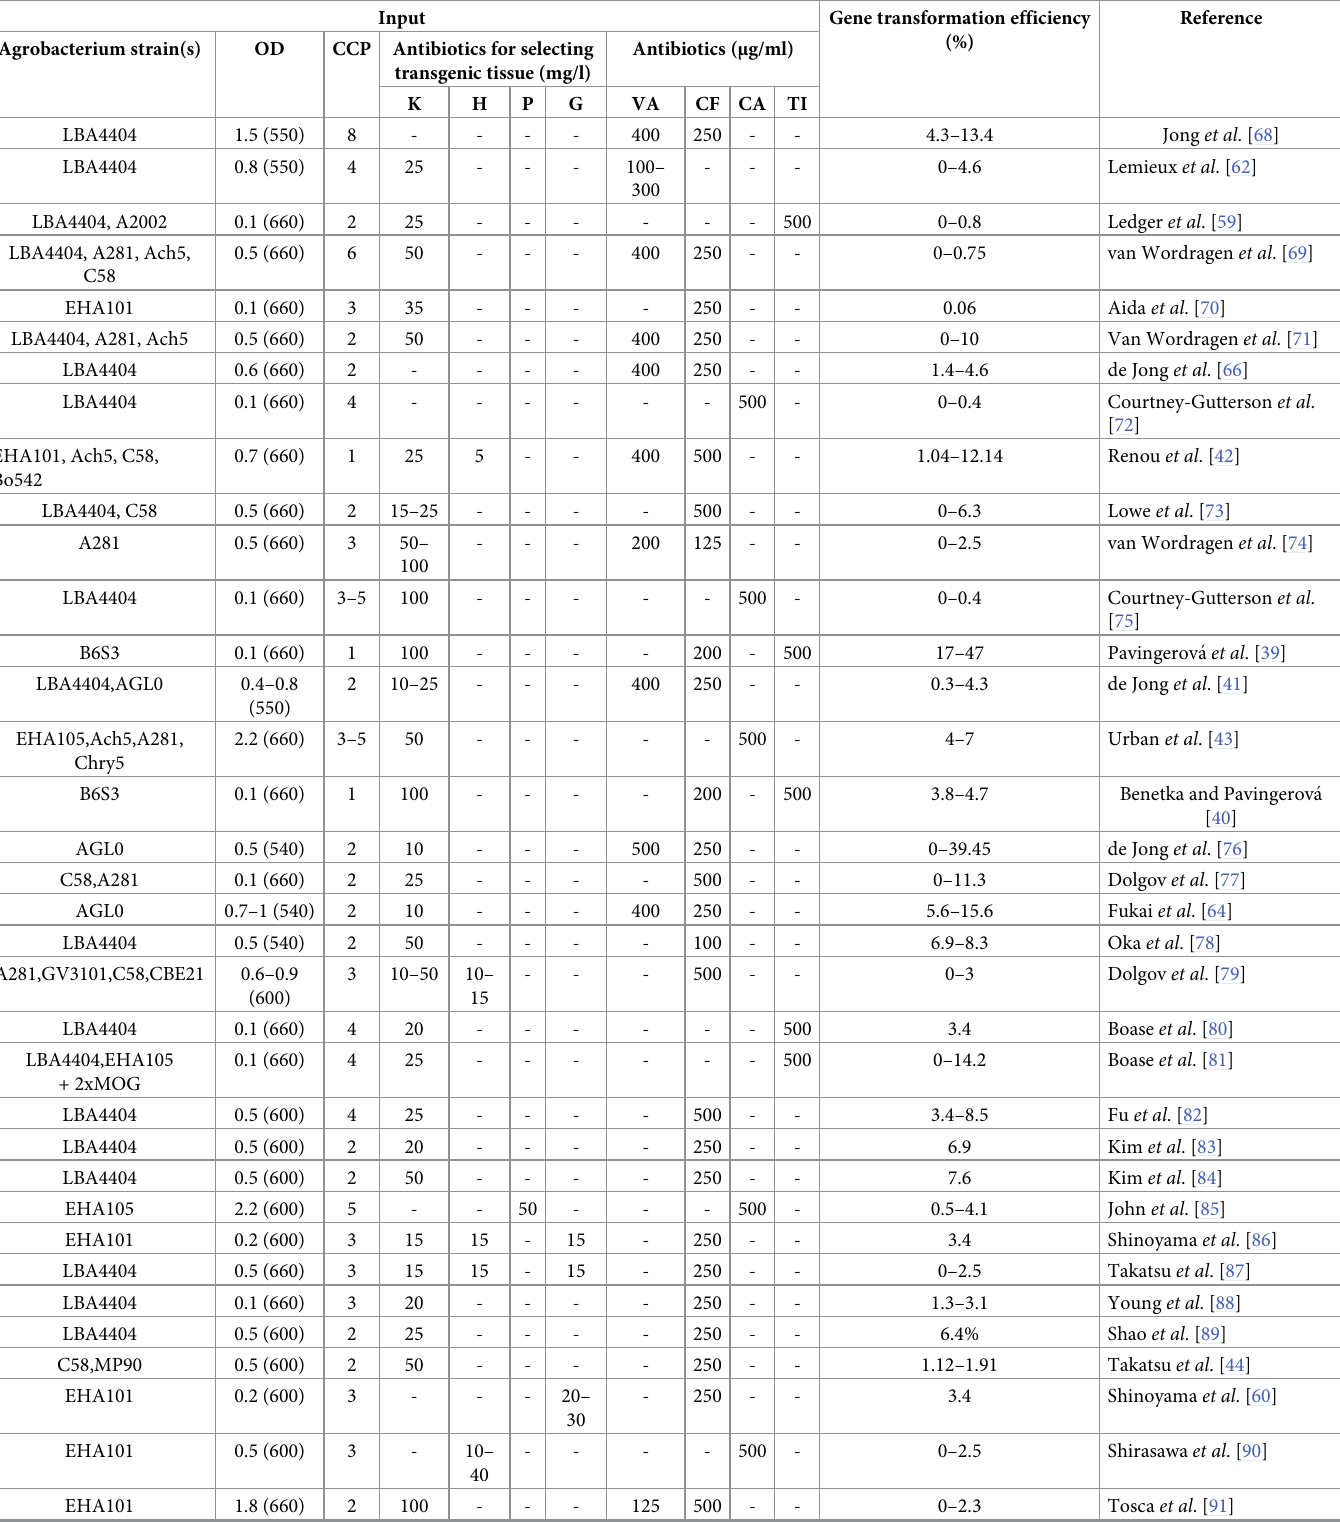
Table 4. Studies on Agrobacterium -mediated gene transformation of chrysanthemums using GUS gene.